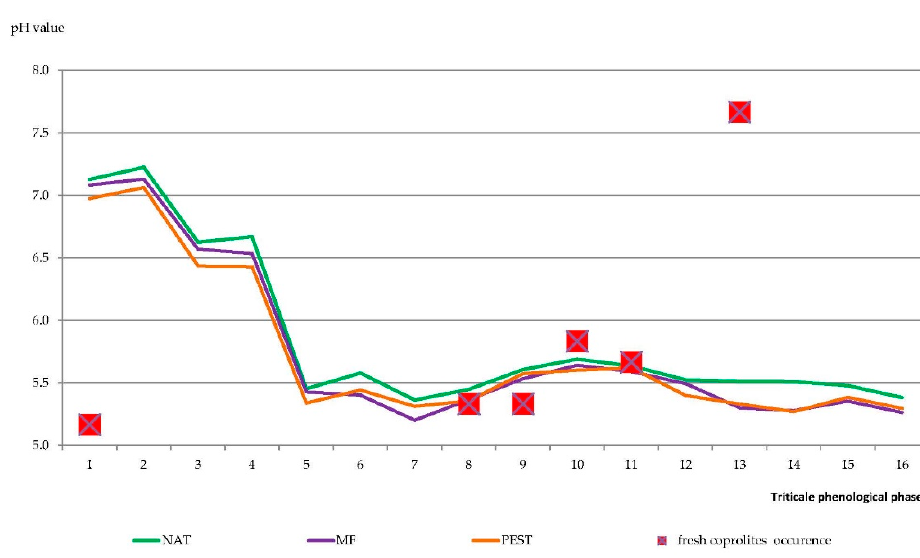
Figure 1. Continuous measurements of pH value in earthworm sampling sites (March 2019–July 2019) according to different triticale management methods. * The distance of red dots from the x -axis represents abundance of monitored sites where fresh coprolites were occurred in the particular terms; the lack of red dots means no fresh coprolites at the monitored sites.